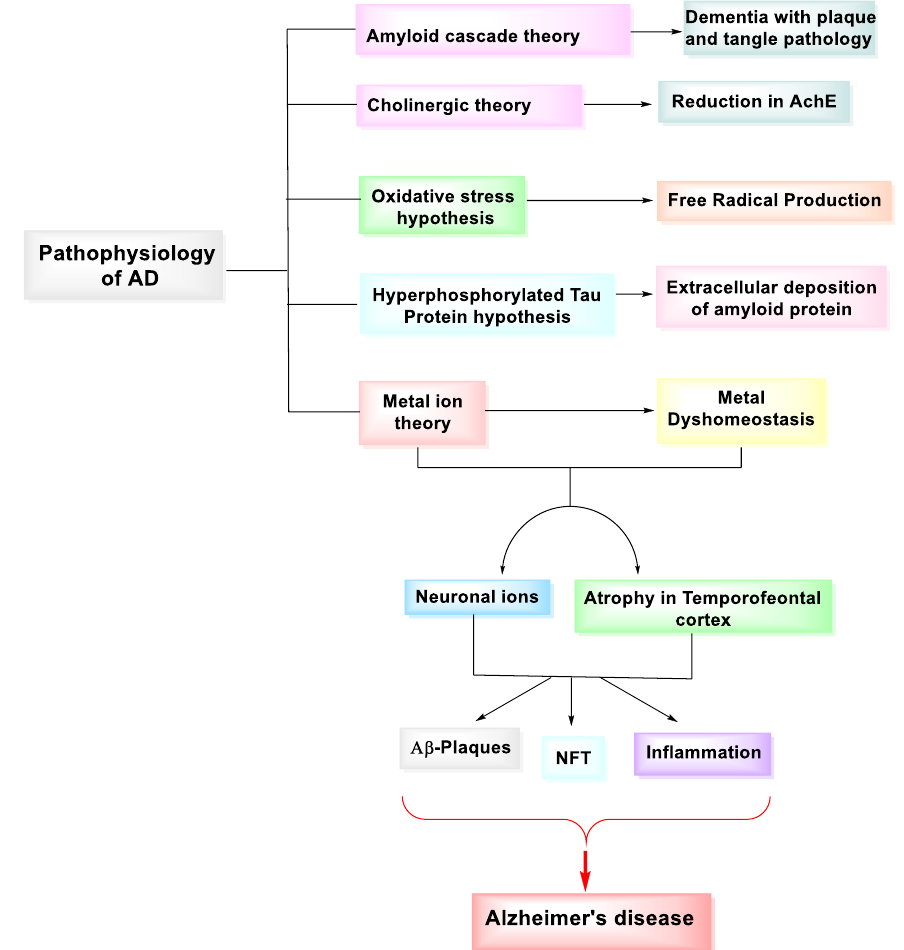
Figure 5. Hypothesis/Theories for the pathophysiology of Alzheimer ’ s